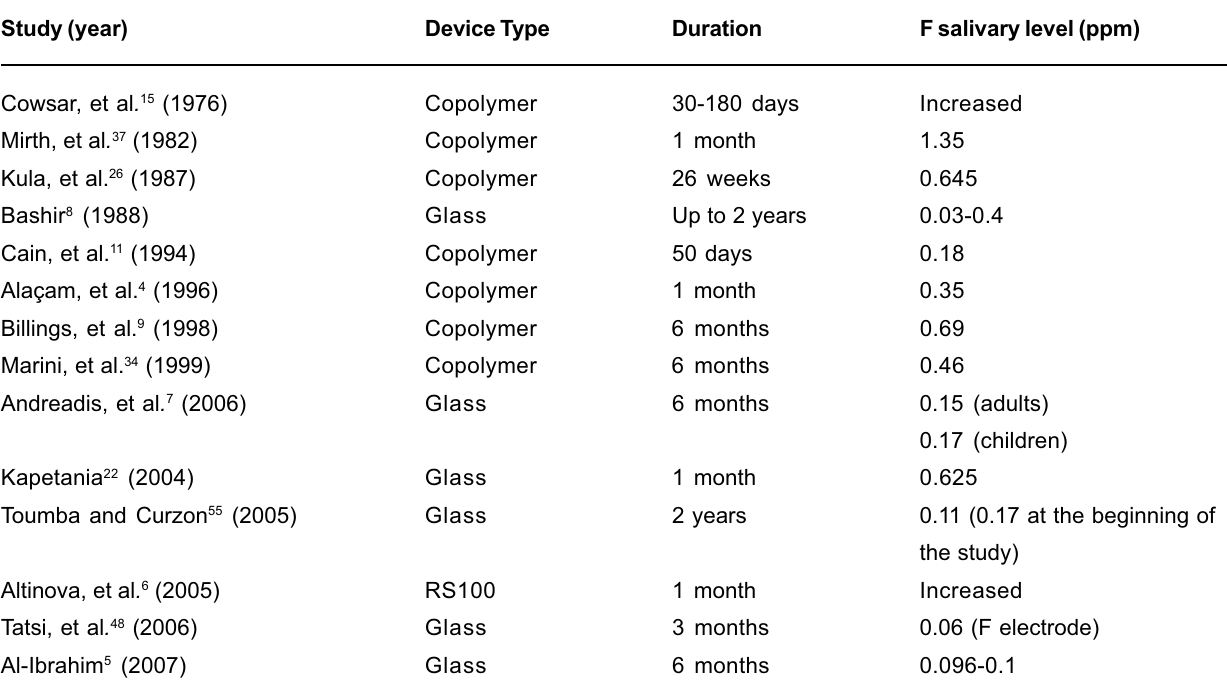
TABLE 3- Reported salivary fluoride levels released by slow release